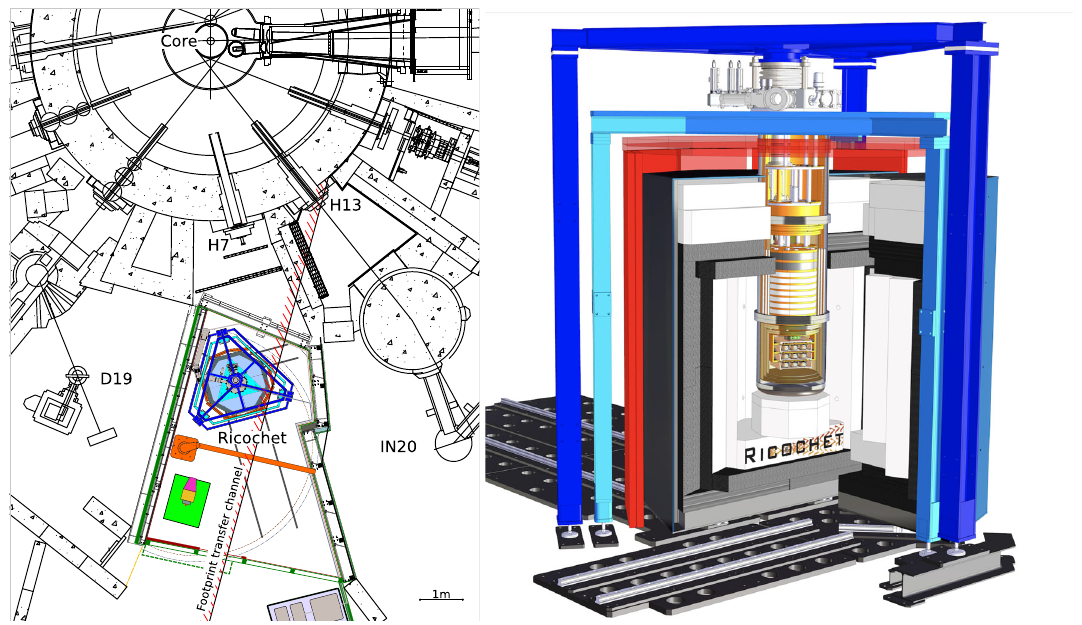
Fig. 1 Left: schematic of the planned Ricochet integration within the ILL-H7 experimental site. The cryostat is mechanically anchored thanks to two triangle-shaped frames surrounding the passive shielding and active muon veto. Also shown are the 1-t crane (orange), the pulsed DT-based low-energy and mono-energetic neutron source in its storage position (light green), and the surrounding IN20 and D19 experiments.